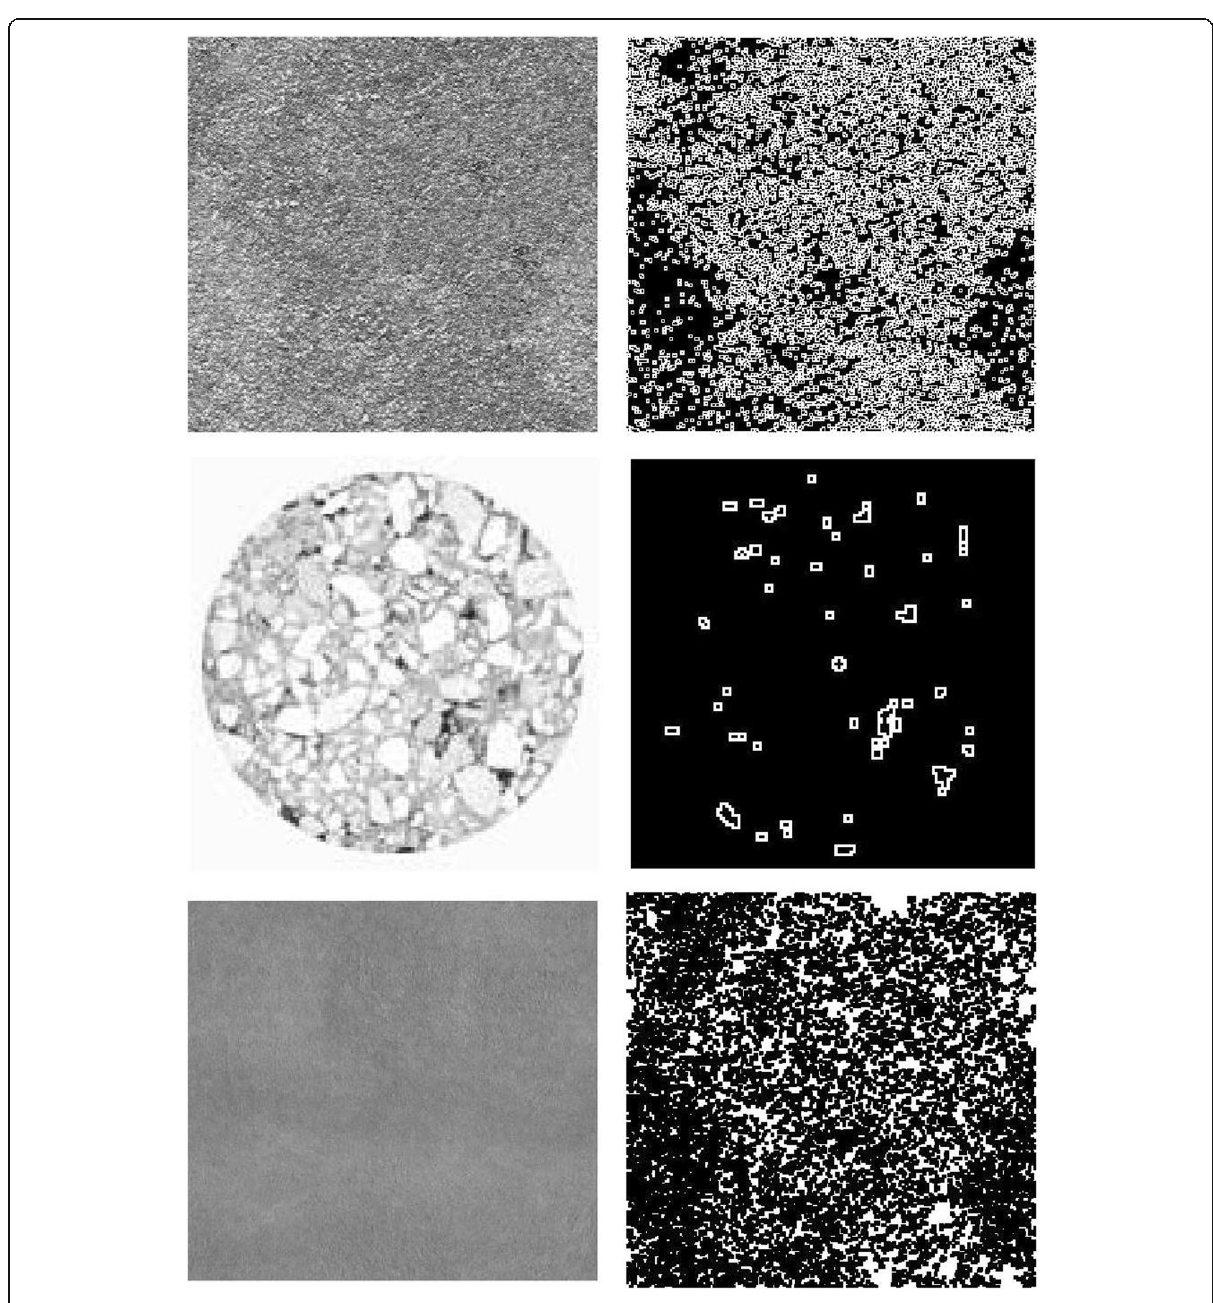
Fig. 5 Image processing of different geotechnical